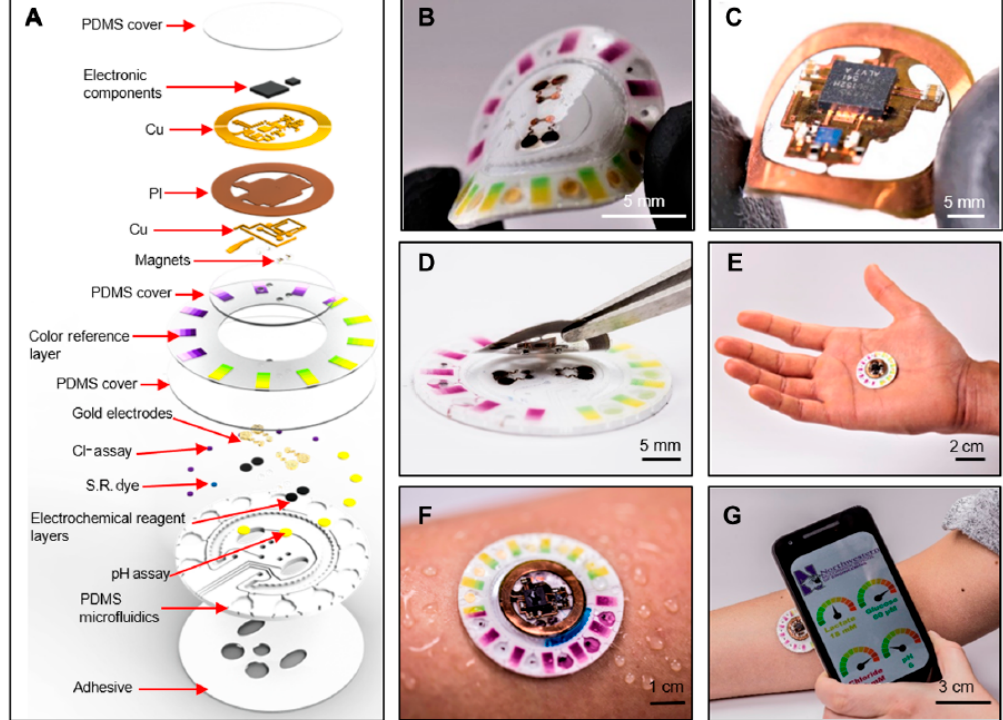
Figure 3. ( A ) Exploded view of the colorimetric / amperometric device. PI: polyimide. S.R.: sweat rate. ( B ) Colorimetric and microfluidic parts of the patch upon bending and ( C ) NFC electronics ( D ) that are placed on top of the patch. ( E , F ) Complete device into a hand and fixed on a forearm. ( G ) Illustration of a smartphone application for wireless communication with the patch. Reproduced from [30]. Copyright © 2019 The Authors, some rights reserved. Distributed under a Creative Commons Attribution Non-Commercial License 4.0 (CC BY-NC).